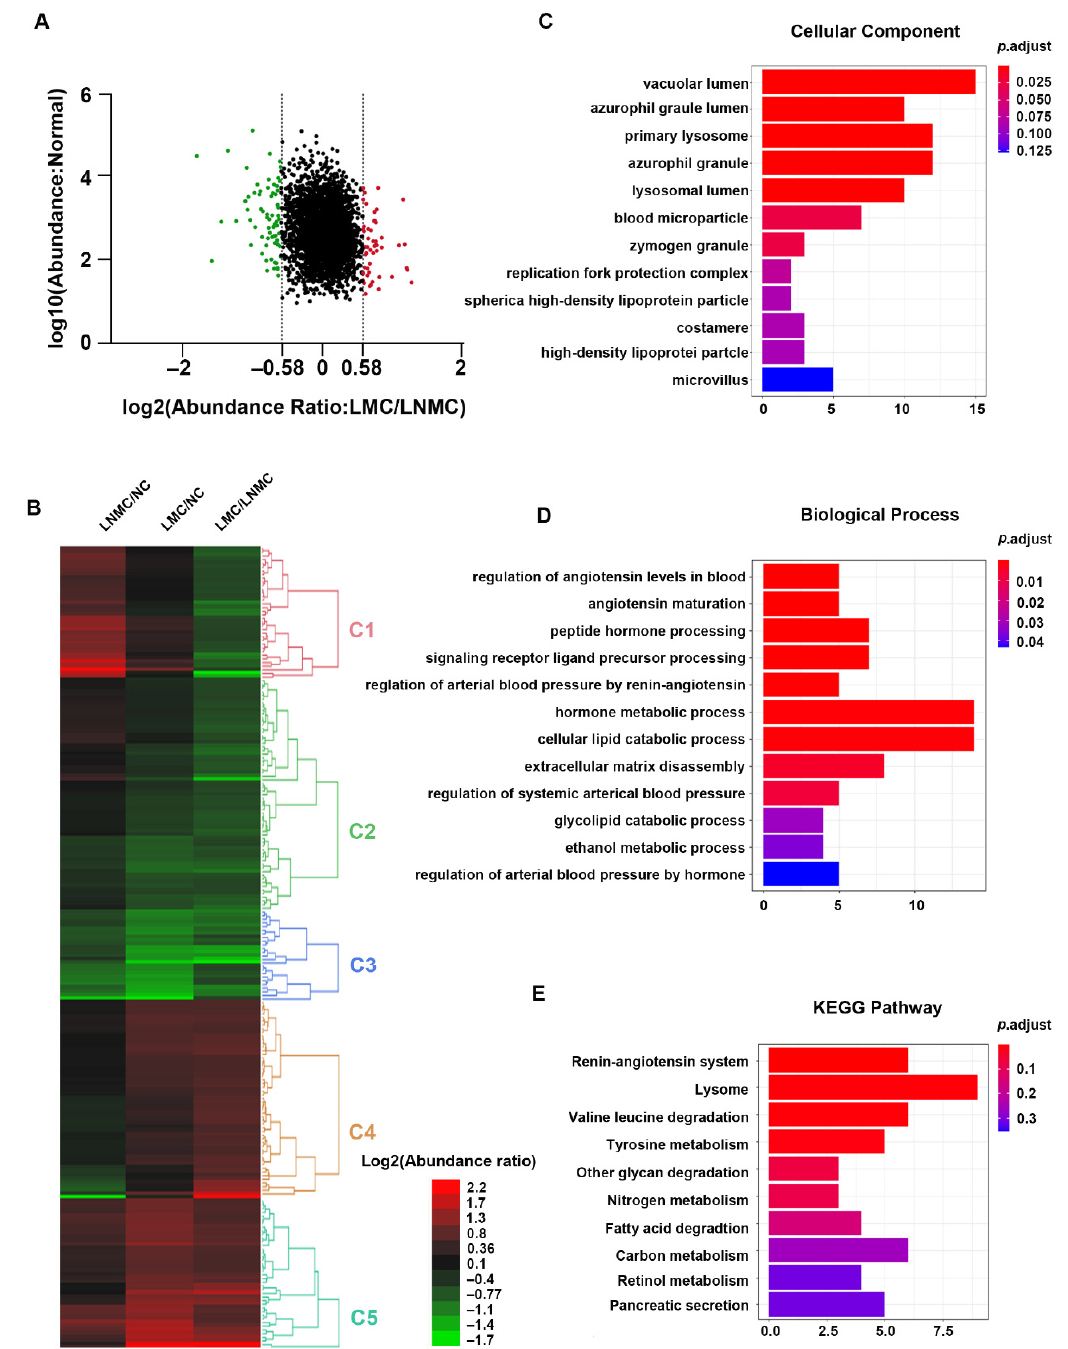
Figure 6. Functional analysis of DEPs between LMC and LNMC. ( A ) Scatter plot showing the distribution of upregulated (red dots) and downregulated (green dots) DEPs. ( B ) Hierarchical clustering analysis and heatmap of DEPs. The heatmap was constructed based on a log2 transformation of relative abundance ratios (LMC/LNMC). ( C , D ) GO analysis indicated the enrichment of these DEPs in cellular component (CC) and biological processing (BP). ( E ) Pathway analysis of DEPs between LMC and LNMC.